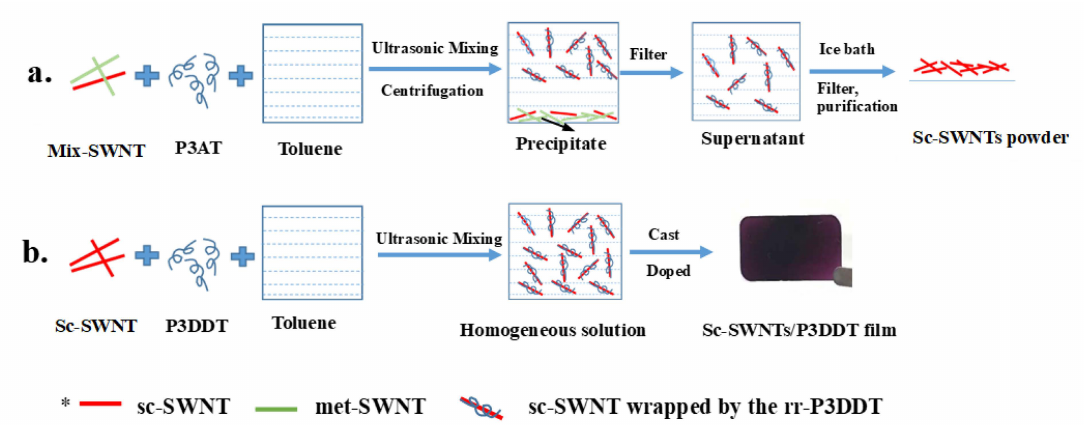
Figure 1. Illustration of the solution process of; ( a ) sorting sc-SWNTs from raw mix-SWNTs; and ( b ) preparing sc-SWNT/P3DDT composite film.